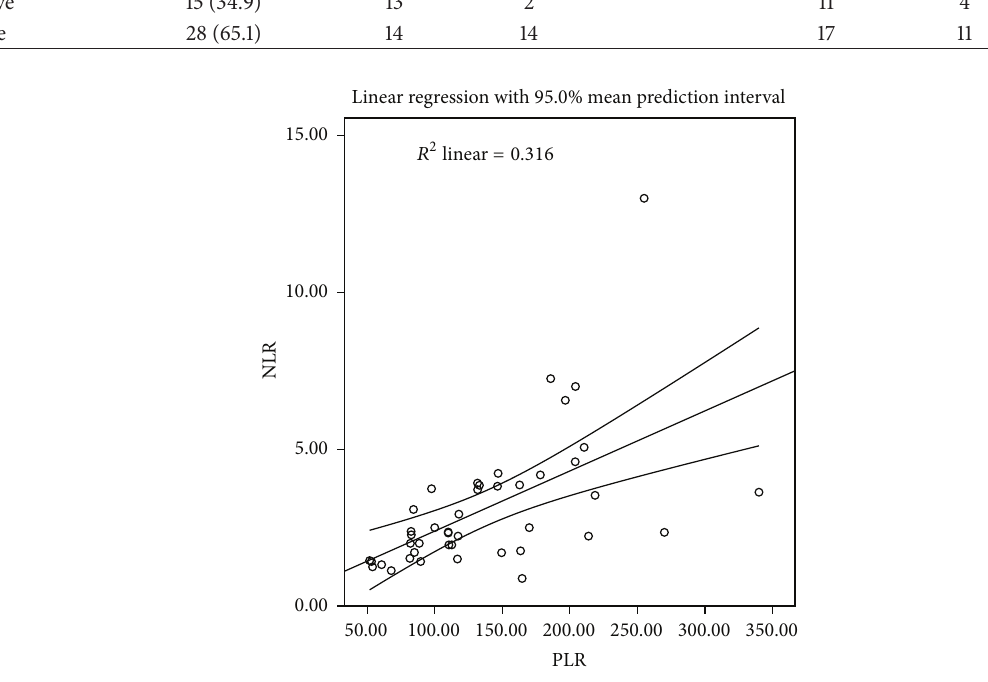
Figure 1: Correlation between the NLR and PLR ( 𝑟 = 0.563 , 𝑃 < 0.001